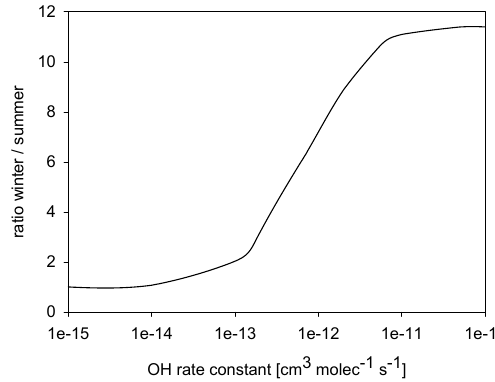
Figure 1. The expected winter/summer ratios (95-/5-percentile) as a function of the OH rate constants for compounds with assumed constant sources in a simplified box model and the mean OH profile determined at